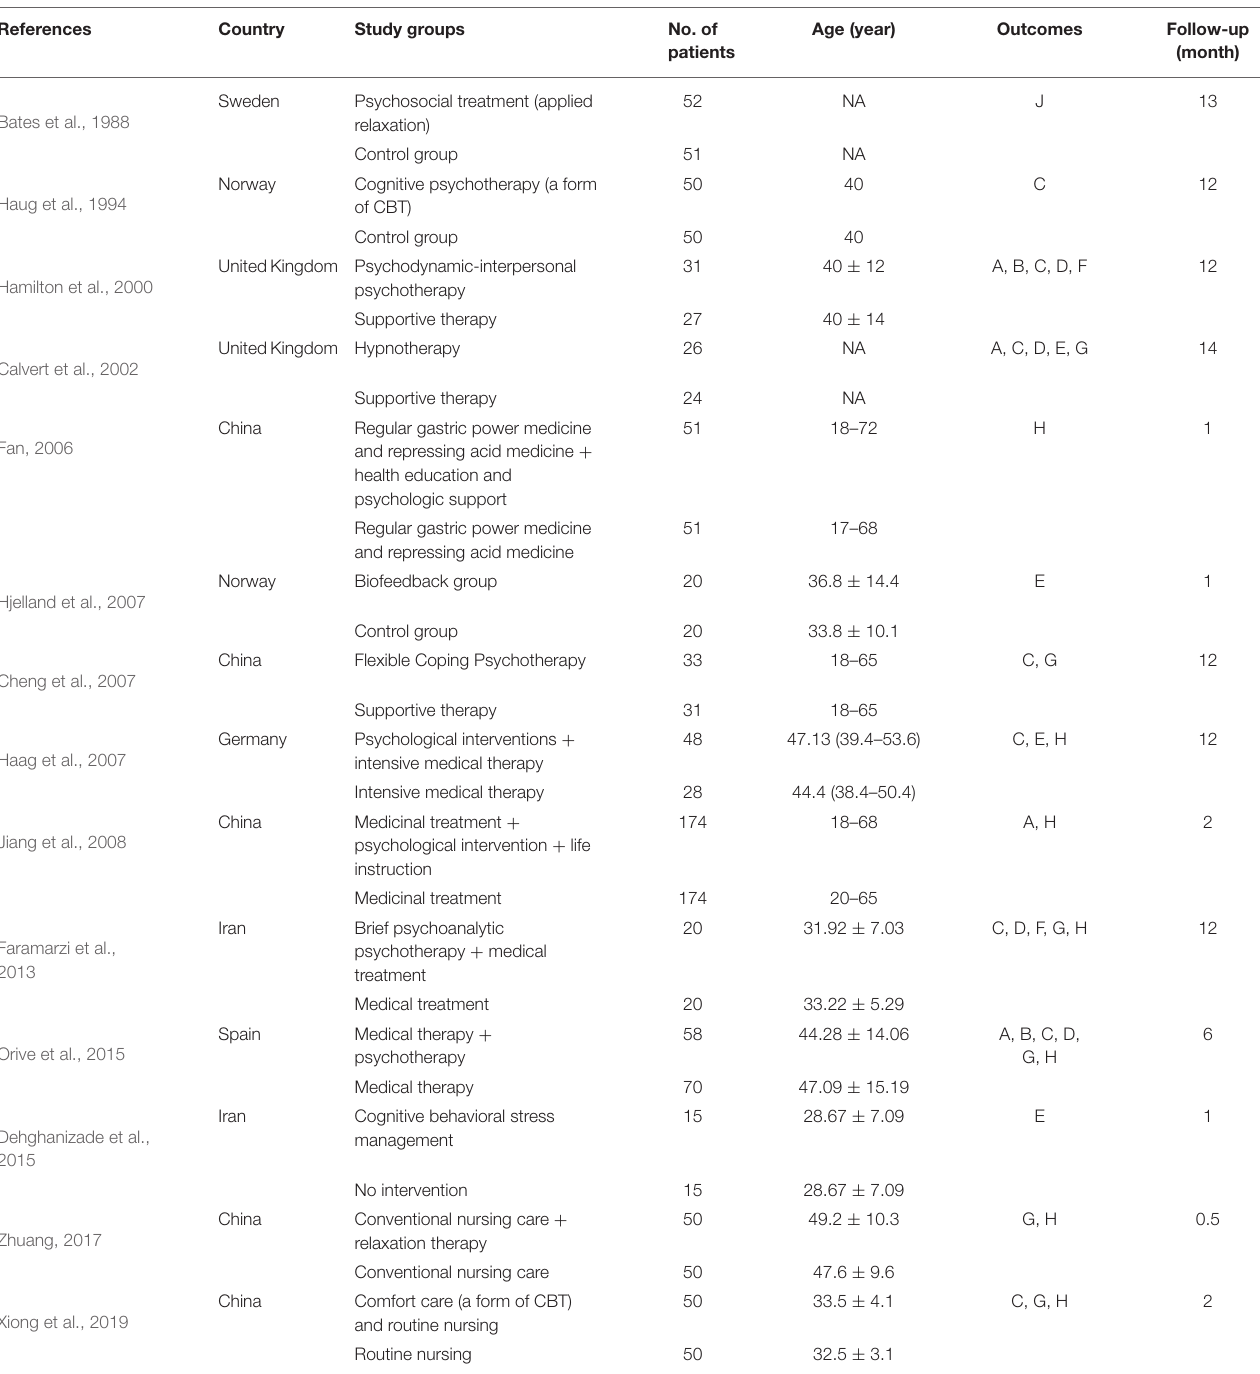
TABLE 1 | Characteristics of the included